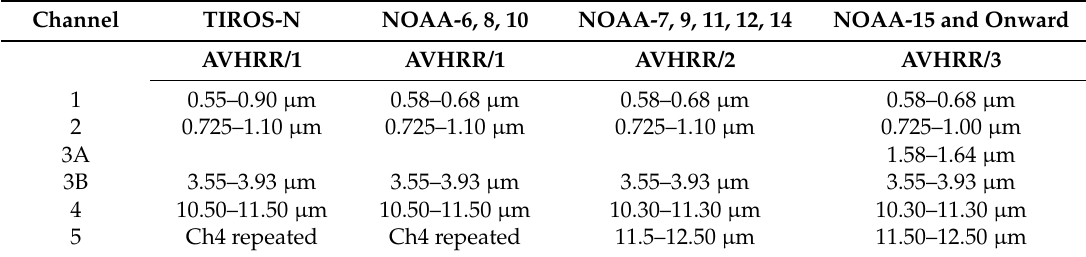
Table 1. Spectral specifications of AVHRR/1,/2, and